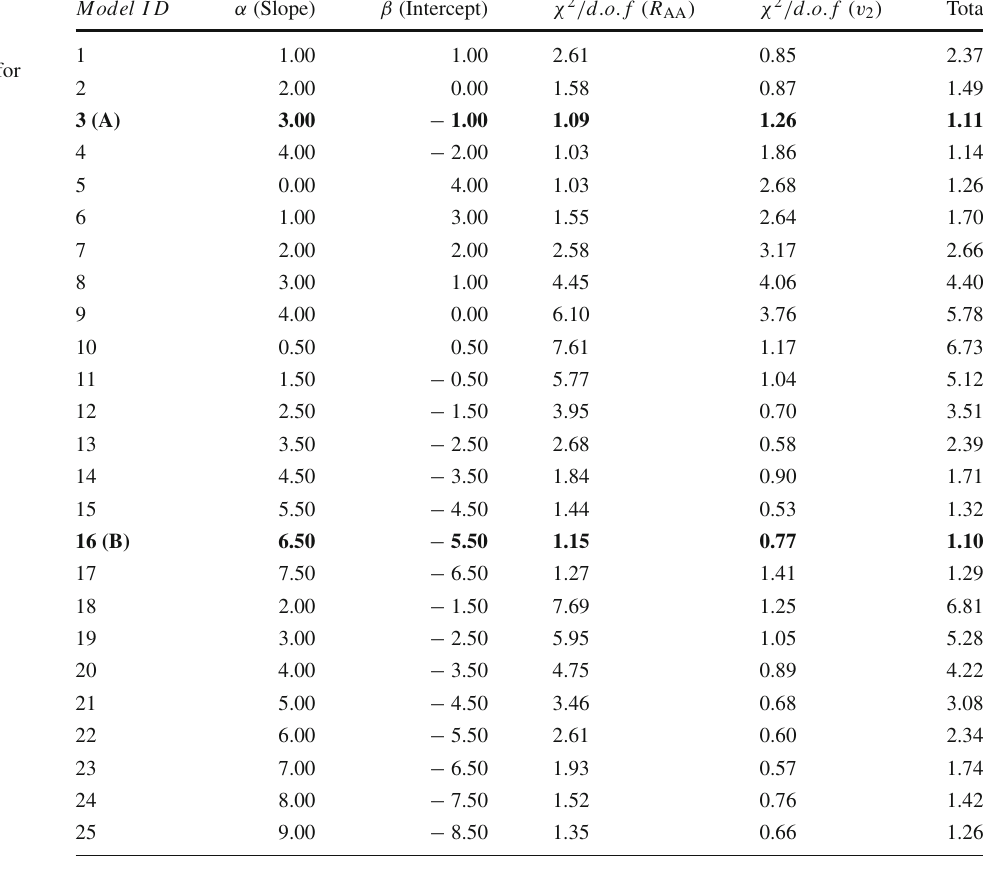
(pink circle [49], red triangle [50] and blue square [51]) as well as consistent with other models [54,56,57]. Toward